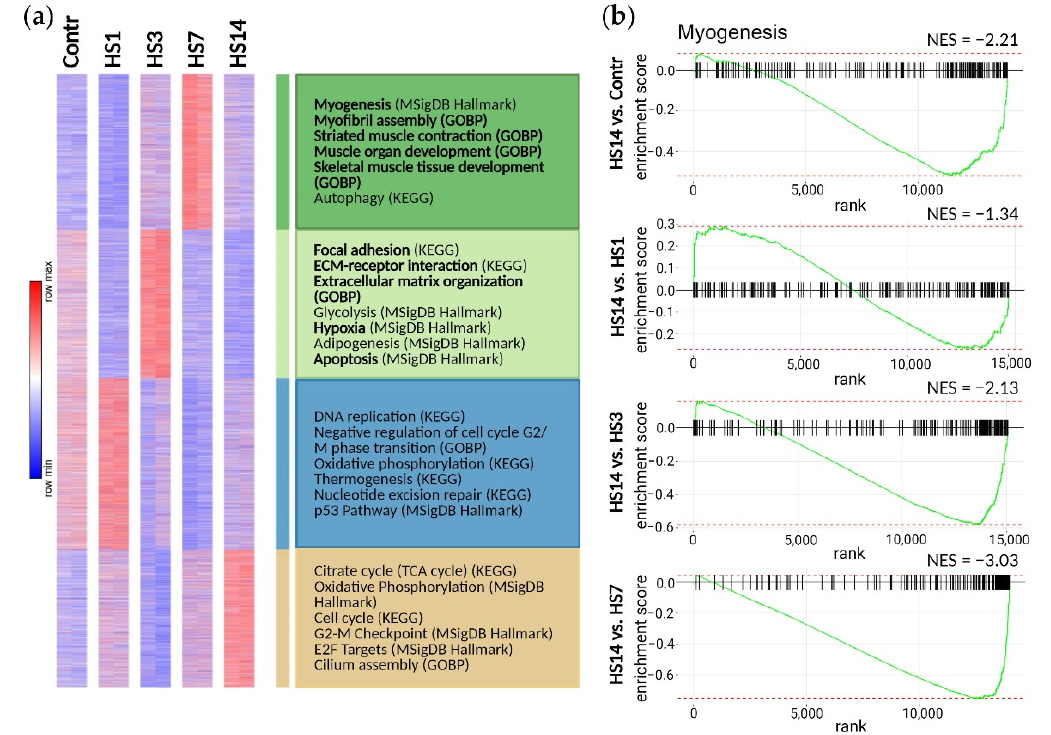
Figure 4. A transcriptome analysis revealed a change in myogenic potential at different time-points of mechanical unloading: ( a ) K-means clustering analysis of 15,829 genes in the Contr, HS1, HS3, HS7 and HS14 samples; ( b ) GSEA enrichment plots of the hallmark myogenesis pathway over ranked genes between possible pairs of cultured myoblasts: Contr, HS1, HS3, HS7 and HS14; p < 0.01, normalized enrichment scores (NES) are shown.